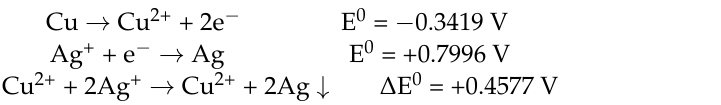
( c ) Figure 18. ( a ) TEM image of Cu-Ag nanowires; EDX mapping element ( b ) Cu; ( c ) Ag. 4. Conclusions In conclusion, the morphology of copper nanowires was investigated by adding var- ious concentrations of a reducing agent, a capping agent, a reagent, and a copper precur- sor, and various reaction temperatures. An excessive amount of N 2 H 4 not only increased the diameter of copper nanowires but also caused an incomplete process of forming the dominant copper nanoparticles. At least 60 ° C was required to prevent aggregations of copper seeds. However, as EDA performed actively at 70 ° C, a smooth surface without aggregations of copper nanowires was observed. In addition, the amount of EDA was controlled to prevent the aggregation of copper seeds. An excessive amount of EDA er- ratically protected copper seeds and resulted in the irregular surface of copper nanowires. Therefore, it is required to interplay with NaOH and CuCl 2 . Copper nanowires synthe- sized under 9 M of NaOH, 50 µL of EDA, 17 mM of CuCl 2 , and 5.7 mM of N 2 H 4 at a reaction temperature of 70 ° C measured more than 18 µm in length and 25–45 nm in di- ameter without the aggregation of copper seeds. Cu-Ag nanowires were successfully fab- ricated by a new green method using DMSO 2 , which has not been reported previously for the fabrication of core–shell nanowires. DMSO 2 acted as a copper surfactant and a silver reductant to initiate a redox reaction while protecting copper ions on the surfaces. The EDX mapping element exhibited the presence of a silver shell on the surface of copper